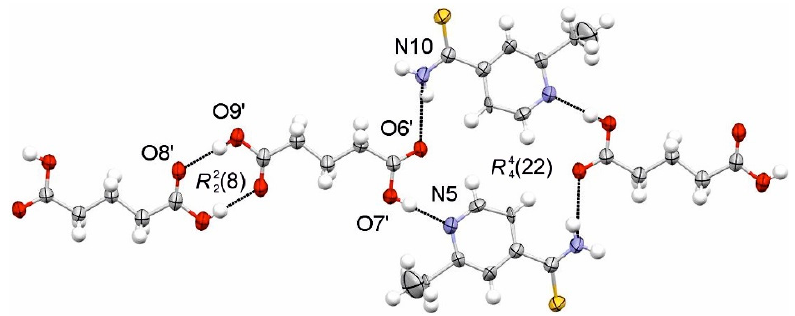
Figure 2. Hydrogen bond (HB) pattern of ETN·GLU, highlighting the centrosymmetric 𝑅 (cid:2870)(cid:2870) (8) dimer and the 𝑅 (cid:2872)(cid:2872) (22) cyclic motif.